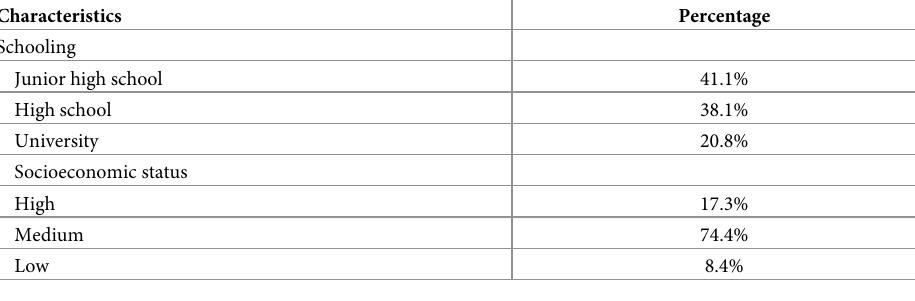
Table 1. Sociodemographic characteristics of the participants (n =